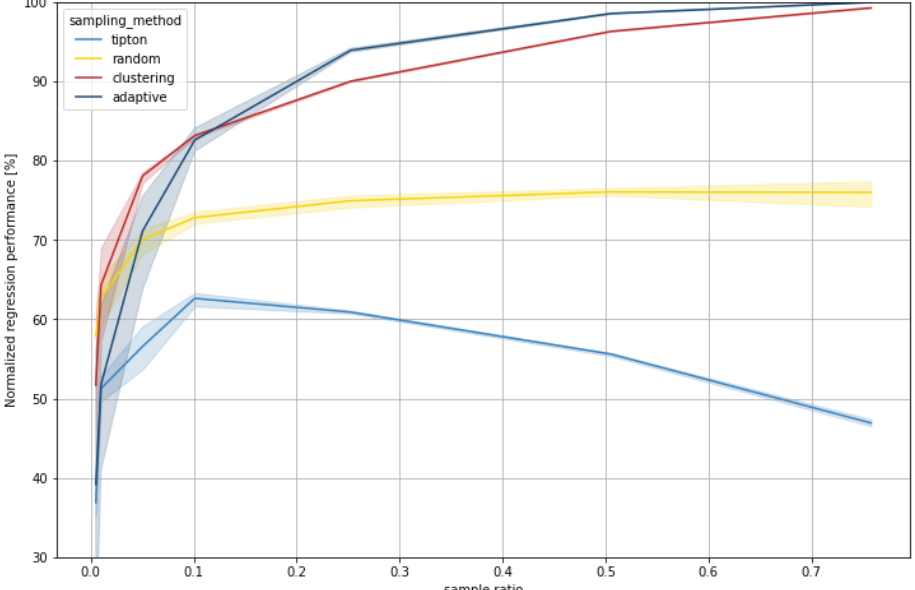
Figure 5. Impact of sampling methods on dataset 1.